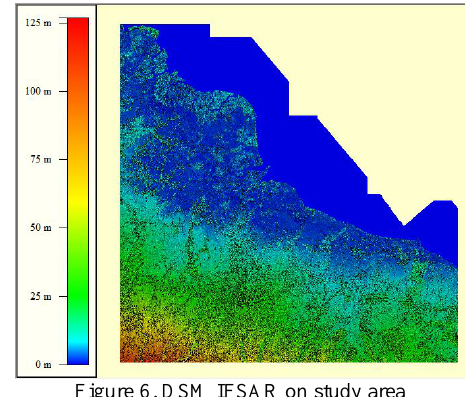
Figure 6. DSM IFSAR on study area b. Topographic maps 1:50.000 scale (2014) generated from